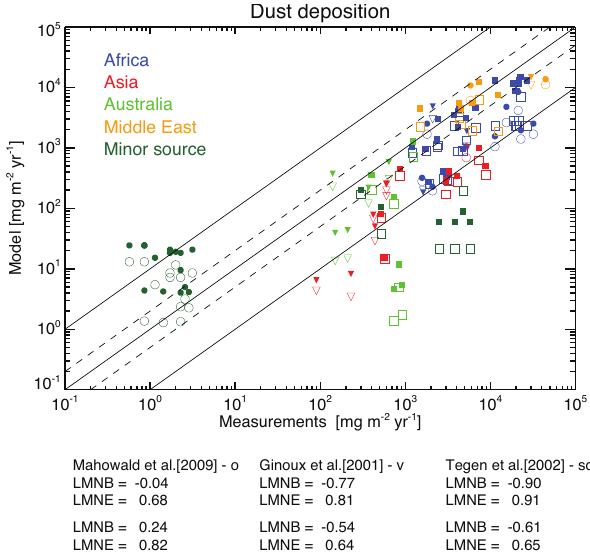
Figure 14. Scatter plot of annual-average dust deposition fluxes (mgm − 2 yr − 1 ) simulated and observations obtained from Ginoux et al. (2001), Tegen et al. (2002) and Table S2 in Mahowald et al. (2009). Open symbols are for ModelE2-TOMAS and the filled symbol for ModelE2-OMA. LMNB and LMNE are presented be- low the plot: the first values are for